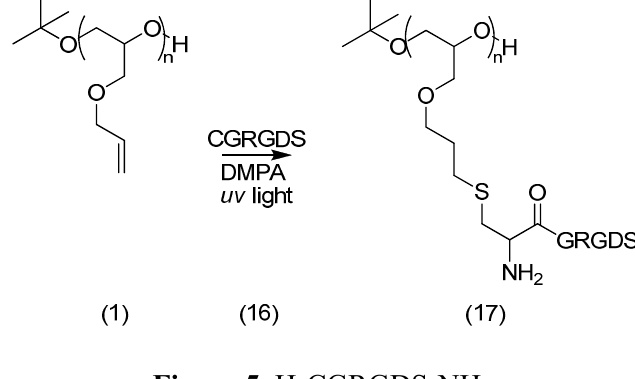
Figure 5. H-CGRGDS-NH 2